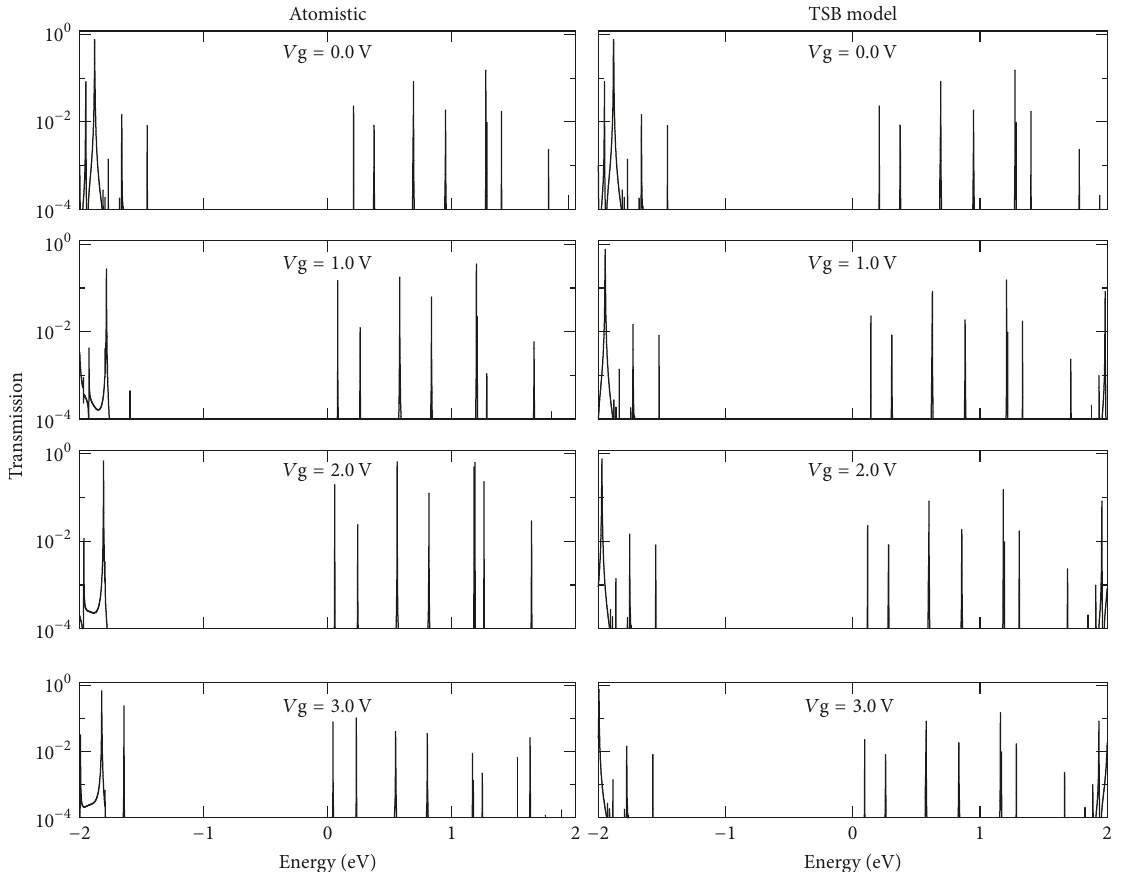
Figure 9: Transmission spectrum for different 𝑉 g ( 𝑉 ds = 0 ). The shift in the transmission spectrum can be observed with change in gate